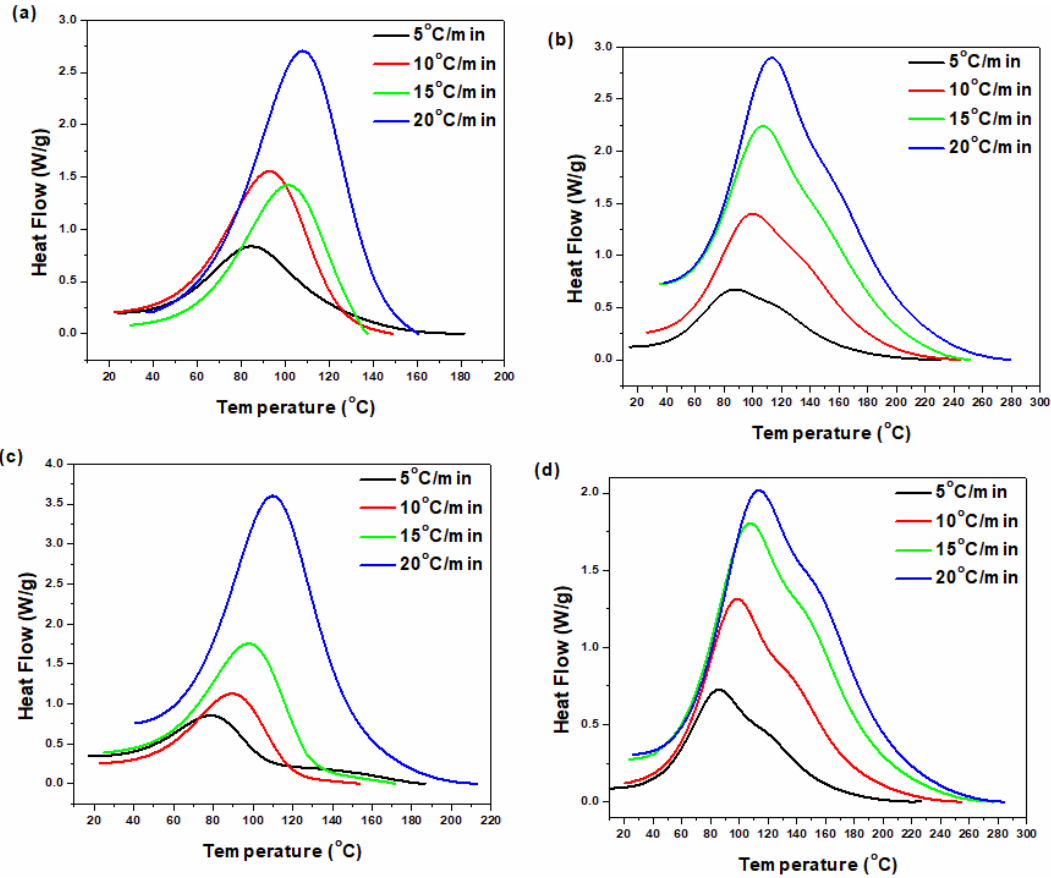
Figure 1. DSC thermographs of the ( a ) neat epoxy, ( b ) epoxy/P-HNT, ( c ) epoxy/A-HNT and ( d ) epoxy/F-HNT at four different heating rates of 5, 10, 15 and 20 ˚C min −1 [27] .